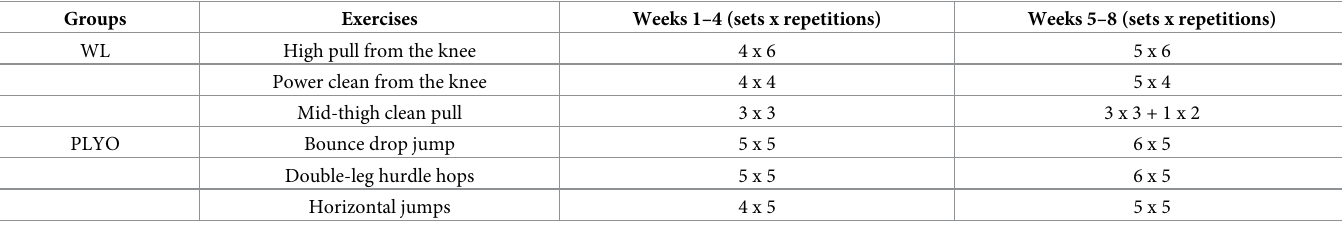
Table 2. Training